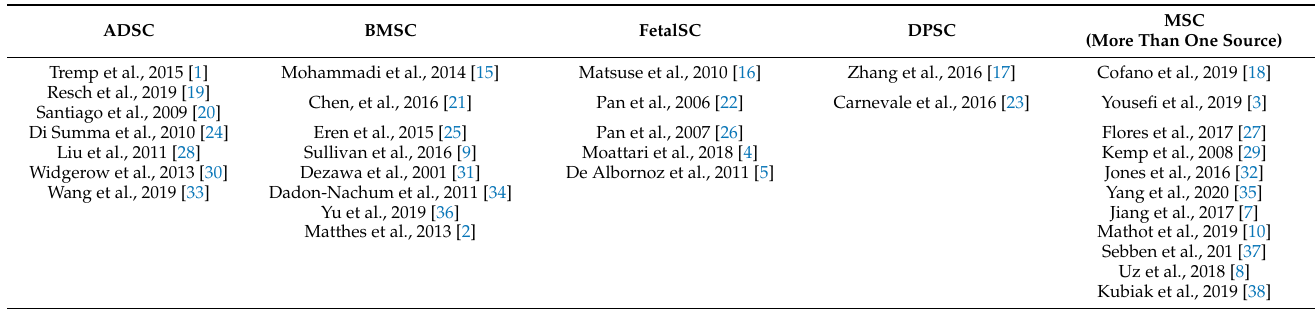
Table 1. Article subdivision depending on the type of mesenchymal stem cell taken into account. ADSC: adipose stem cells; BMSC: bone marrow stem cells; FetalSC: fetal stem cells; DPSC: dental pulp stem cells. Studies with more than one stem cell source are reported in the final column.